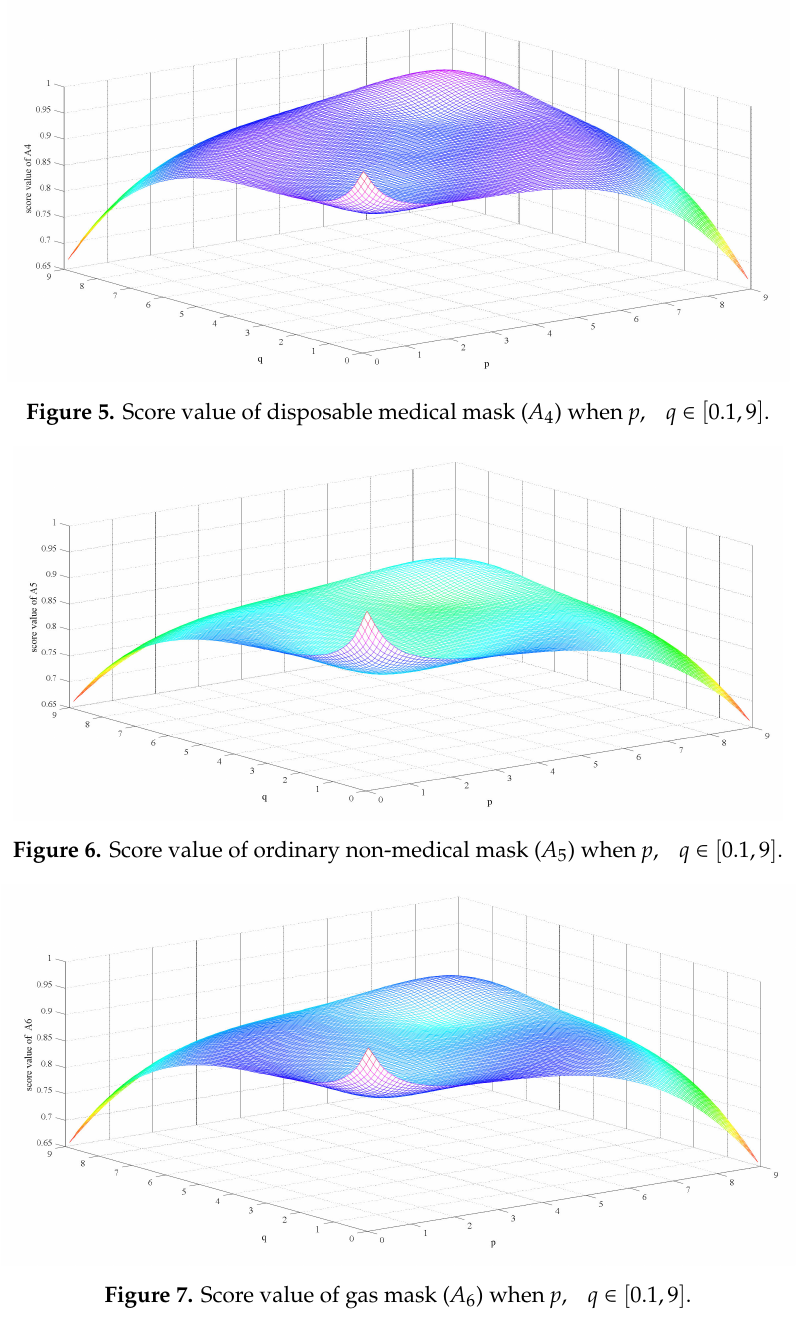
Figure 7. Score value of gas mask ( A 6 ) when p , q ∈ [ 0.1,9 ]